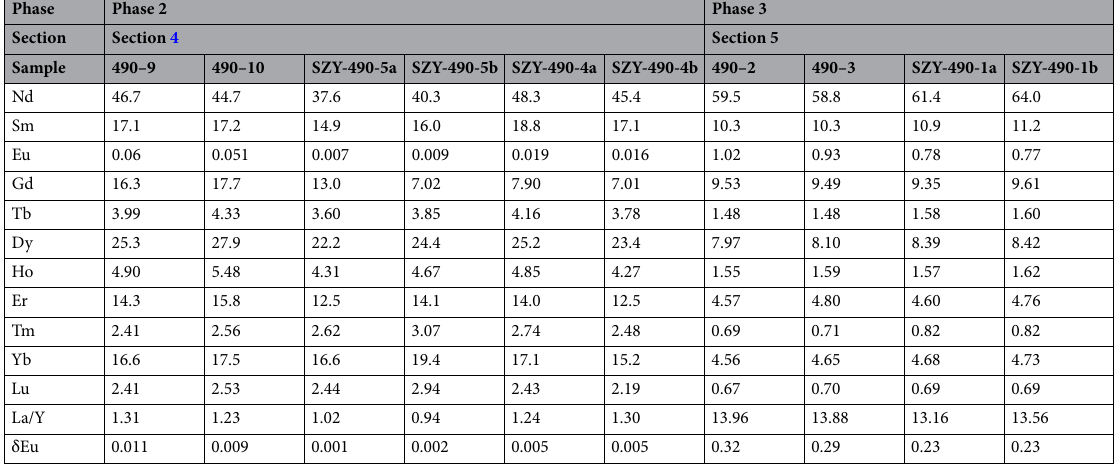
Table 3. Major and trace element composition of samples from the main intrusive stages of the QGC. LOI, Loss on ignition; LLD, Lower limit of